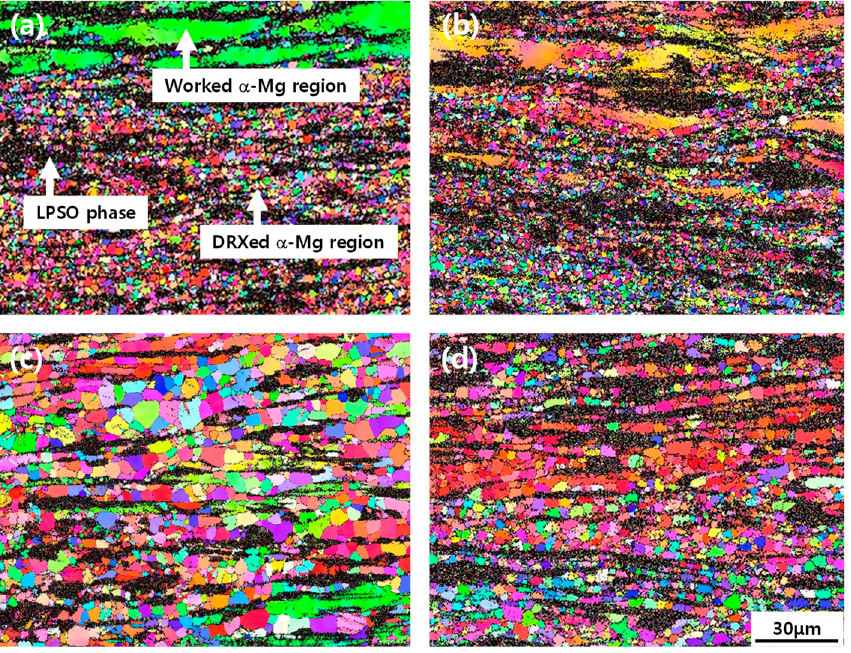
Figure 9. Inverse pole figure (IPF) maps of extruded ( a ) Mg 88.5 Zn 5 Y 6.5 and ( b ) Mg 88.5 Zn 5 Y 5.0 Ce 1.5 ; heat-treated ( c ) Mg 88.5 Zn 5 Y 6.5 and ( d ) Mg 88.5 Zn 5 Y 5.0 Ce 1.5 .